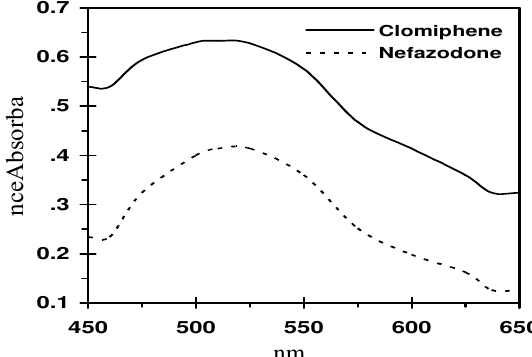
Figure 1. Absorption spectra of the complex formed through reaction of 1.6 mg/mL clomiphene and nefazodone with ammonium